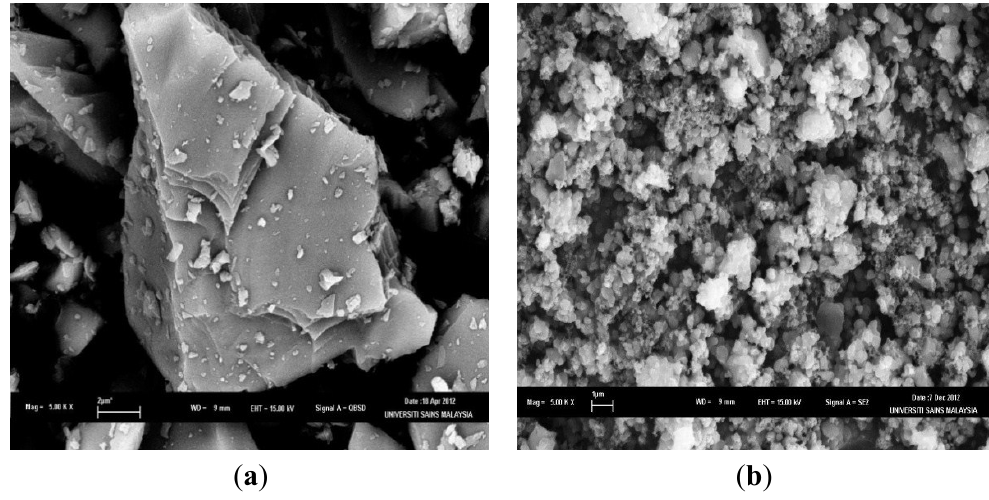
Figure 1. SEM images of ( a ) powdered silicon and ( b ) porous silicon (PS) powder after 4 min of